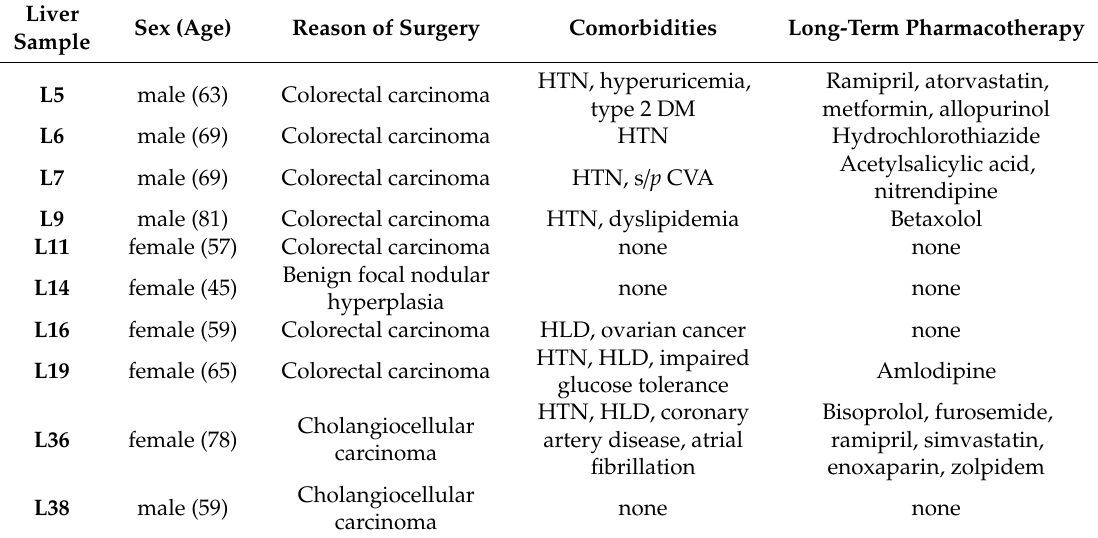
Table 1. Brief medical history of liver tissue